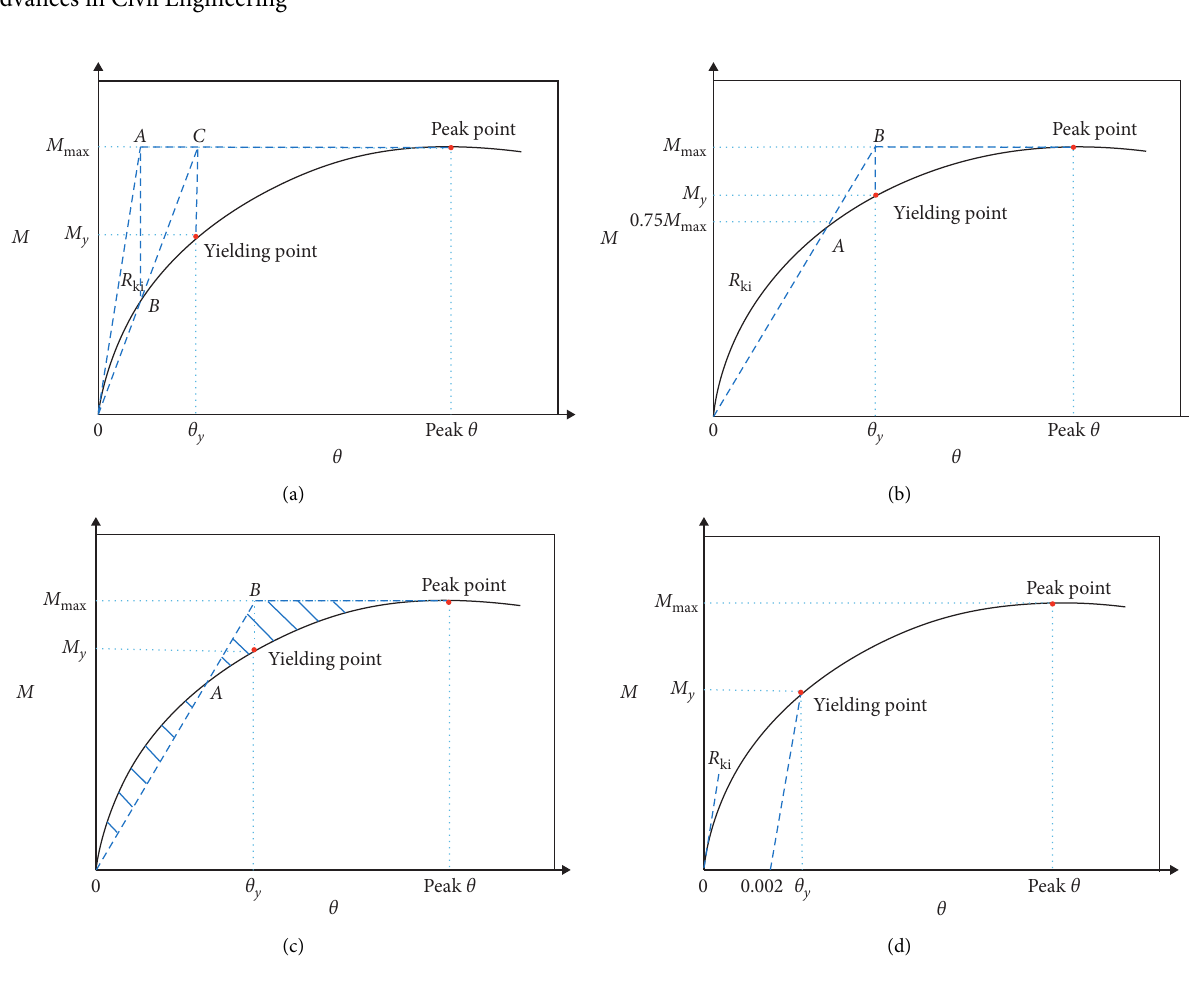
Figure 11: Key parameter definition of